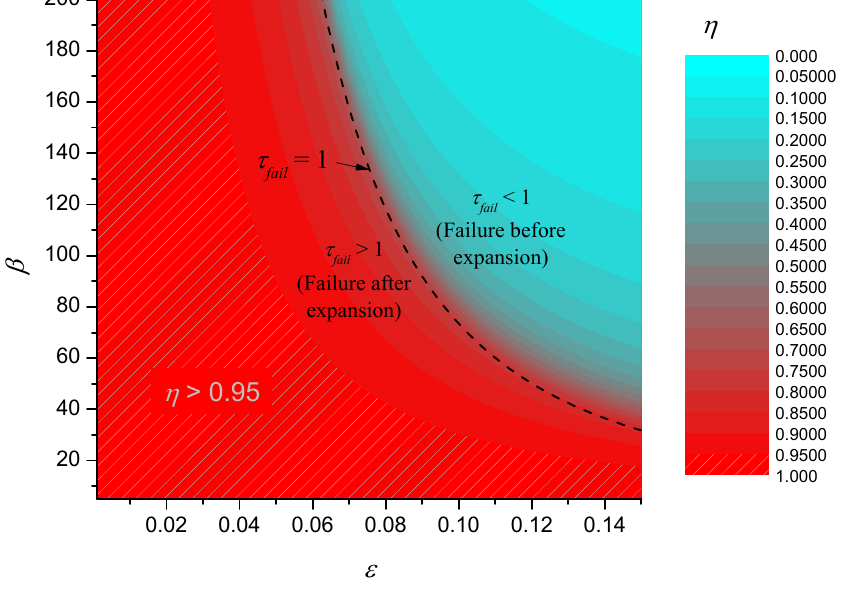
Figure 9. Efficiency of simple expanding char